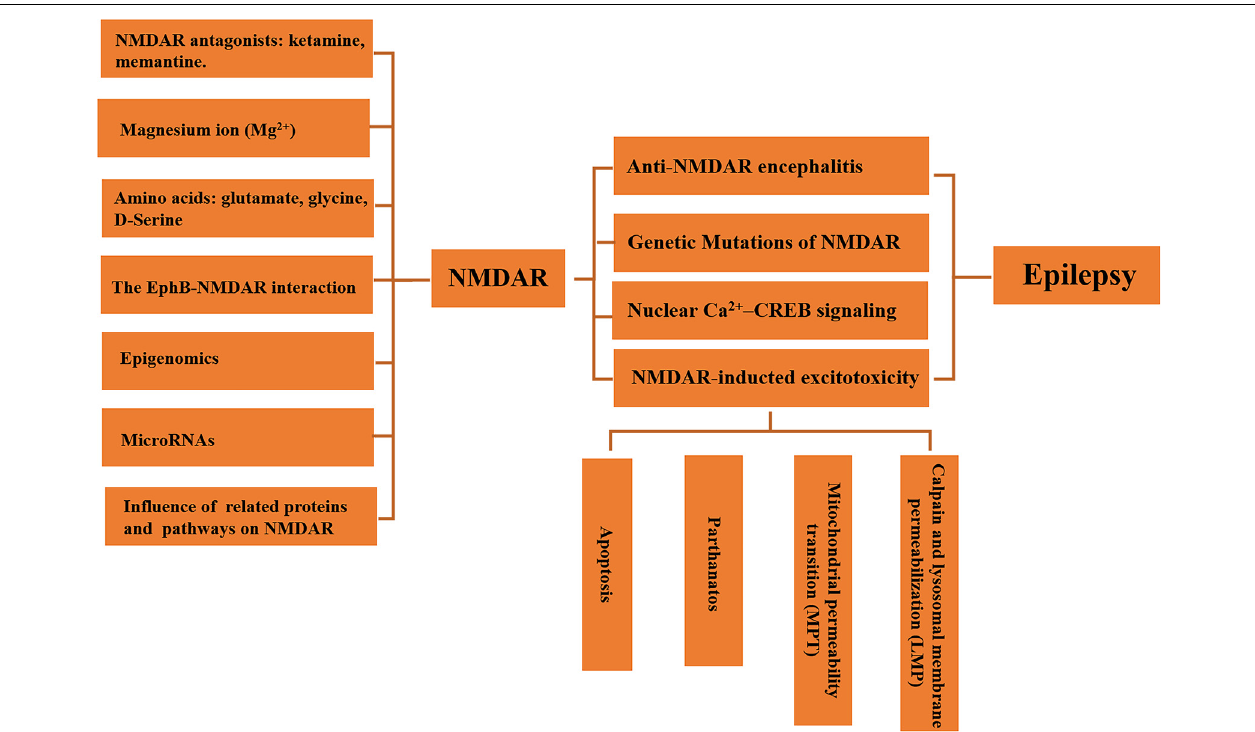
FIGURE 1 | Regulation of neuroexcitatory receptor N-Methyl-D-Aspartate Receptor (NMDAR) in